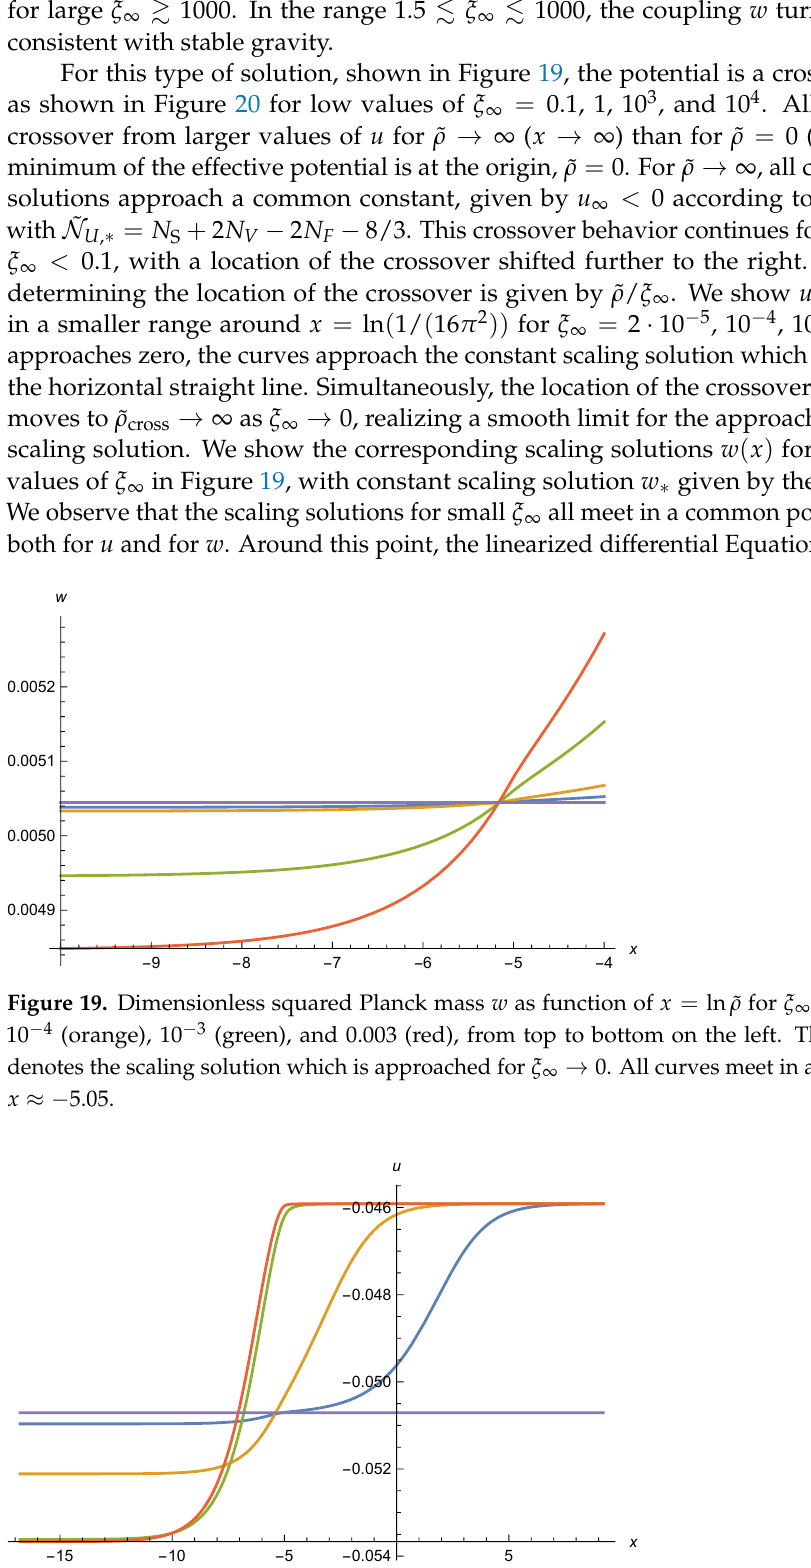
Figure 20. Effective potential u as function of x = ln ˜ ρ for ξ ∞ = 0.1 (blue), 1.0 (orange), 10 3 (green), and 10 4 (red), from right to left in the right part and from top to bottom in the left part. The horizontal line indicates the scaling solution. The particle content is the one of the standard model, N S = 4, N V = 12, and N F =